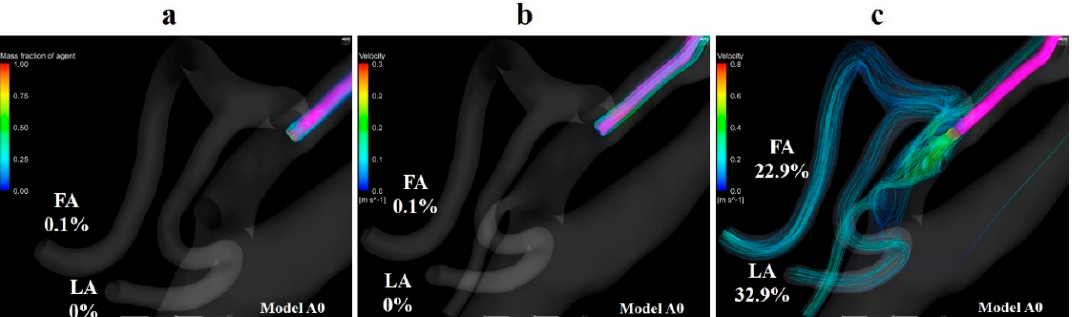
Figure 8. Volume-rendering image and streamlines in model A0. ( a ) Volume-rendering image of the mass of agent in model A0 with injection condition of the syringe driver, ( b ) streamlines originate from the catheter tip in model A0 with injection conditions of the syringe driver, ( c ) streamlines originate from the catheter tip in model A0 with injection conditions of the syringe driver. The number of figures shows the distribution rate of the agent. FA, facial artery; LA, lingual artery.